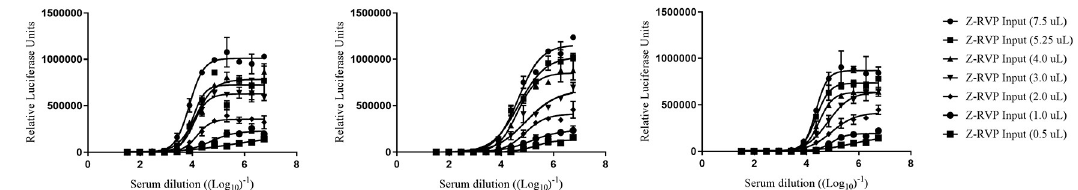
Fig 3. Neutralization curves of Z-RVP dilutions. Neutralization curves of different dilutions of Z-RVP to determine the effects of Z-RVP input against Serum 1, 2 and 3. Neutralization titers in log 10 EC 50 titers are shown as calculated by nonlinear regression in GraphPad Prism for each Z-RVP dilution.